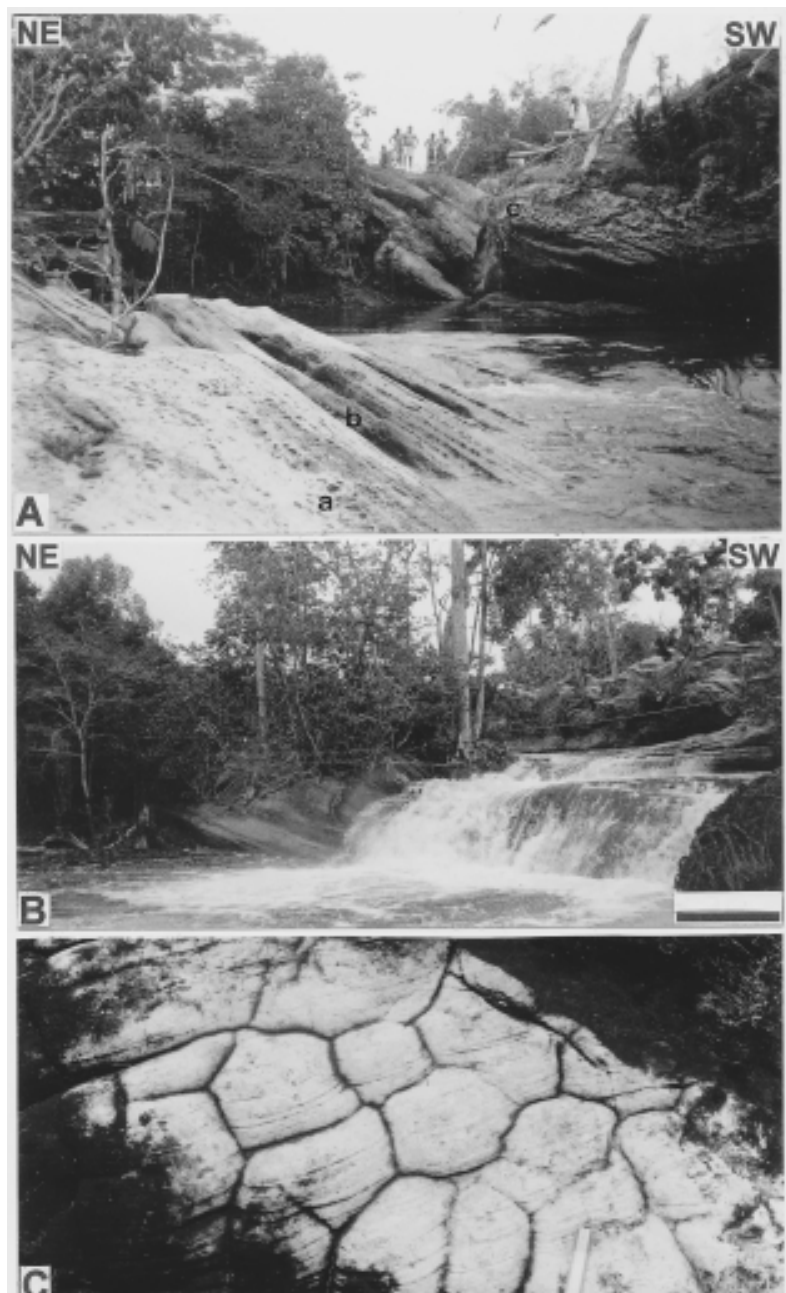
Fig. 4 – Morphologic aspects of the Portal das Cachoeiras Waterfall. A) The subsequent behavior of the Mutum River flowing on rotate beds of the Nhamundá sandstones. The letters "a", "b" and "c" refer, respectively, the pot hole feature, Skolithos -like traces detached by erosive water action, and honeycomb structure. B) Obsequent main fall (flow contrary to the dipping). Scale bar is 3m. C) Polygonal